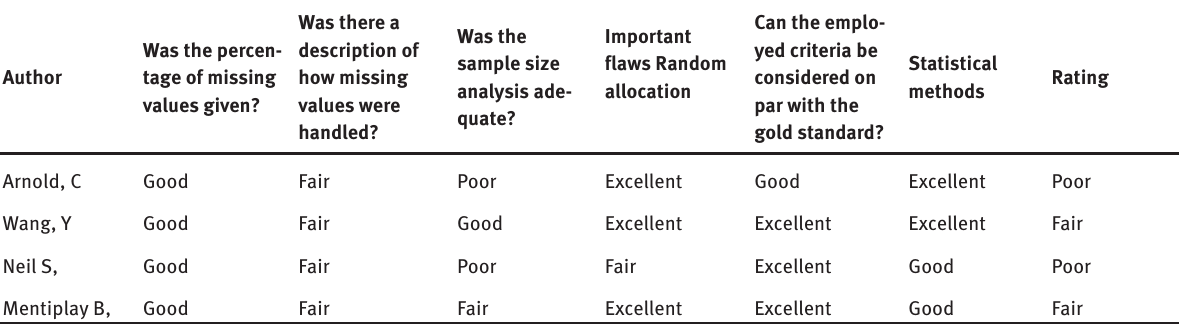
Table 6: Methodological quality by COSMIN checklist of the studies analyzing concurrent validity between HHD and